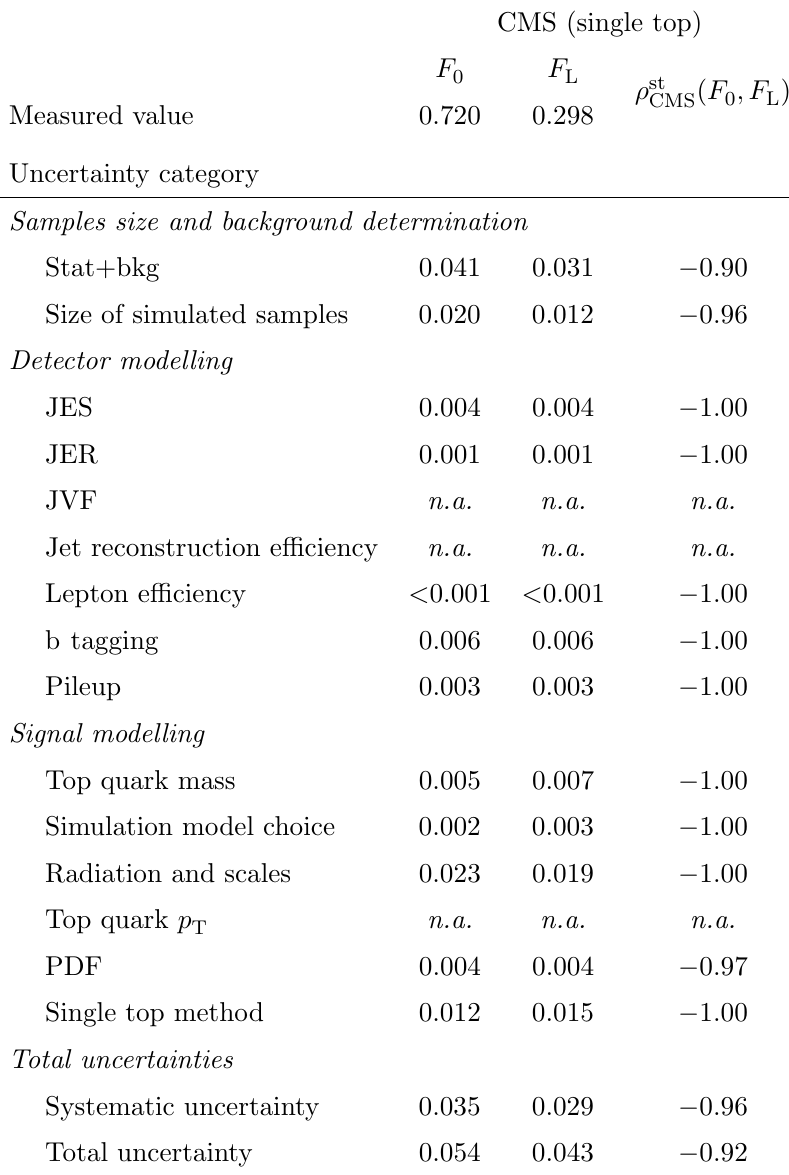
Table 4 . Uncertainties in F , F and their corresponding correlations from the CMS (single top) 0 L measurement. The uncertainty that is not applicable to this measurement, or which is included in other categories, is indicated by \ n.a. ". The line \Systematic uncertainty" represents the quadratic sum of all the systematic uncertainty sources except for the uncertainties in the background de- termination and the integrated luminosity, which are included in the \Stat+bkg" category. The quoted correlation values are obtained via the procedures described in section